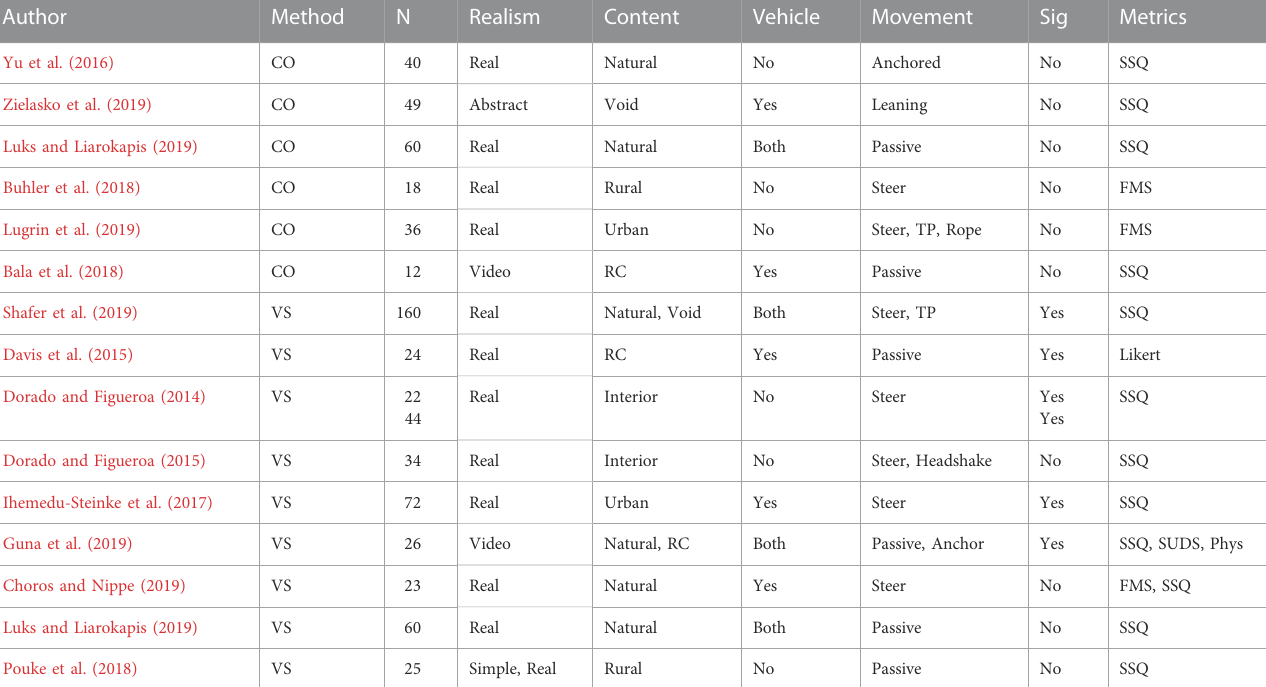
TABLE 1 ( Continued ) Table of collected data from the fi rst fi ve categories of accepted papers. These Categories are Virtual Camera Manipulation (VC), Image Manipulation (IM), Field of View (FOV), Companion Object (CO), and Virtual Scene Design